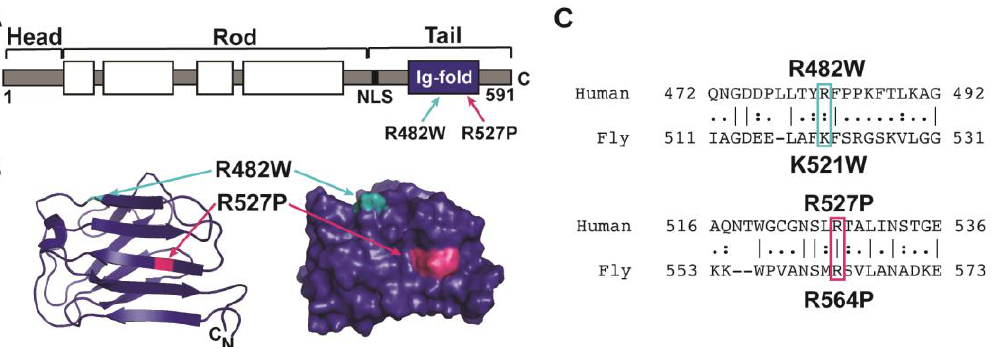
Figure 1. A-type lamins have three conserved protein domains. ( A ) Diagram of lamin A/C showing the head, coiled-coil rod, and tail domain that possesses a nuclear localization sequence (NLS) and an Ig-like fold domain. ( B ) Ribbon diagram of the Ig-like fold domain (PDB: 1IVT) showing the position of the two amino acid substitutions studied here (arrows). ( C ) Amino acid sequence comparison of human lamin A/C and Drosophila LamC is shown for the sequences surrounding the amino acid substitutions studied here. Amino acid R482 in human lamin A/C is a conserved K521 in Drosophila LamC. Amino acid R527 in human lamin A/C is identical between the two species and corresponds to R564 in Drosophila LamC.